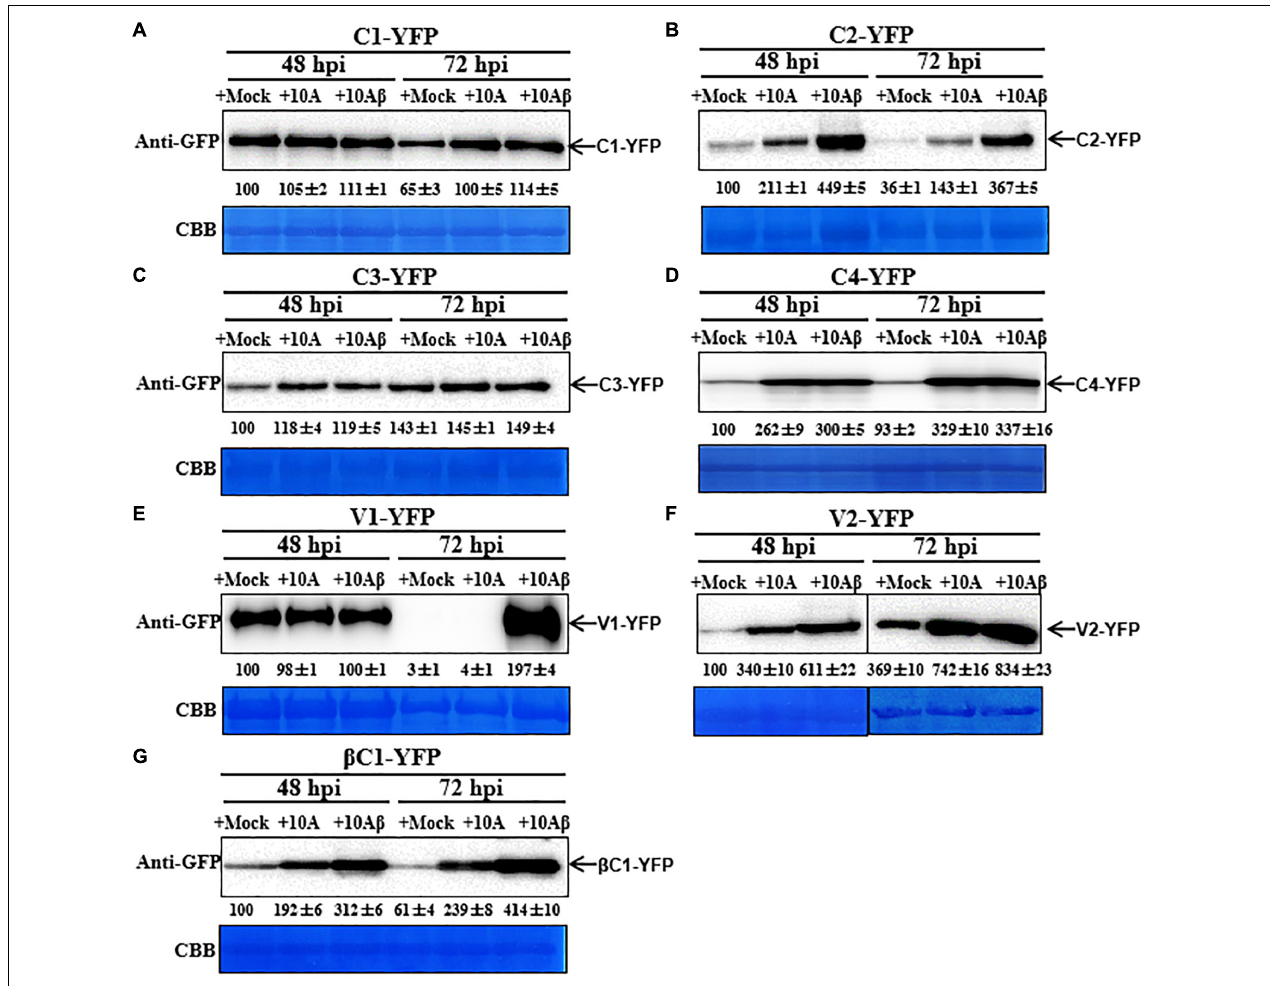
FIGURE 5 | Dynamic changes in the accumulation of viral proteins in the presence or absence of TYLCCNV (10A) or TYLCCNV/TYLCCNB (10A β ). Wild type N. benthamiana leaves were infiltrated with Agrobacterium cultures to express C1-YFP, C2-YFP, C3-YFP, C4-YFP, V1-YFP, V2-YFP, or β C1-YFP together with those harboring an empty vector (Mock), or TYLCCNV or TYLCCNV/TYLCCNB infectious clones. (A–G) C1-YFP, C2-YFP, C3-YFP, C4-YFP, V1-YFP V2-YFP, or β C1-YFP proteins detected by western blot. Total proteins were extracted from infiltrated leaves as indicated at 48 and 72 hpi, and detected with an anti-GFP antibody. The sample volume was 20 µ l (A–E) or 10 µ l (F,G) . All immunoblotting assays in these figures were repeated at least three times, and each experimental sample derived from three individual infiltrations. One representative blot is shown. CBB-stained Rubisco large subunit was used as a loading control. The values of C1-YFP, C2-YFP, C3-YFP, C4-YFP, V1-YFP, V2-YFP, or β C1-YFP at 48 hpi were quantified by Image J and set to 100 for normalization.